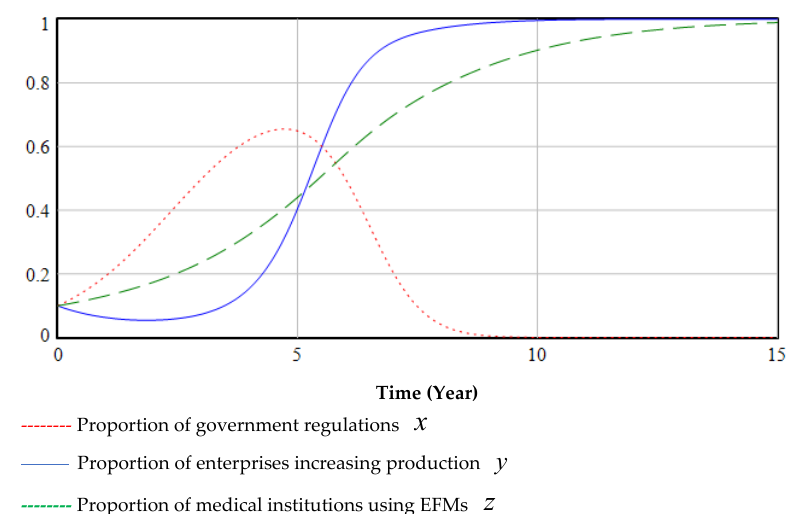
Figure 8. Stability test of ESS point (0, 1, 1).